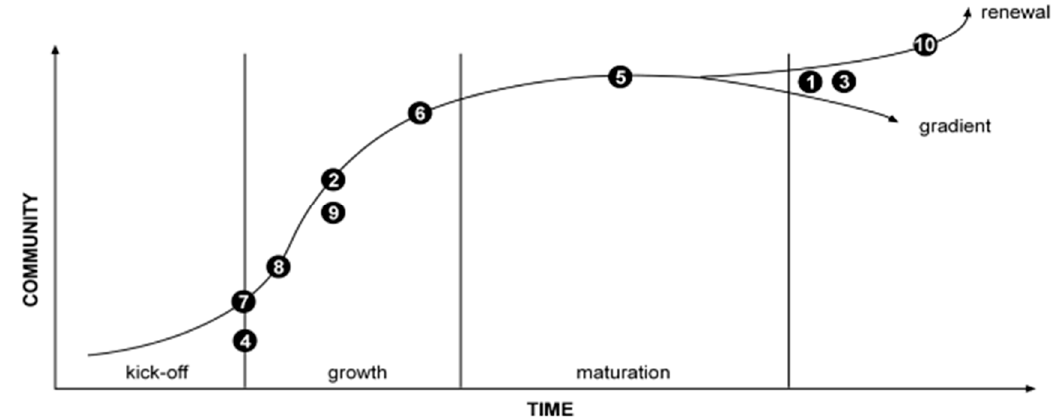
Figure 2. Summary of project stage evolution: (1) El Recetario; (2) SmartIB; (3) Goteo; (4) Katuma; (5) Bdtonline; (6) XOBB; (7) FreeSound; (8) eReuse; (9) Sentilo; (10) Pam a Pam.